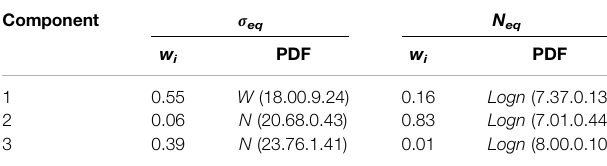
TABLE 2 | The statistical model of equivalent fatigue loading effects in the upstream side. Component